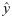
Liquid-state machine computations. In order to test the functional impact of the AIS location and the bandwidth of the transfer gain, we simulated a network of exponential Integrate-and-Fire (eIF) units using parameters fit to models with different AIS locations (see Fig 6 and Table 3). (A) The input was fed to a pool of recurrently connected neurons (black and blue: excitatory, red: inhibitory). Neurons were connected randomly through dynamic synapses. The filtered spikes (liquid states) of a subset of excitatory neurons (output neurons, blue), was used as input to a linear classifier. (B) The network input consisted of jittered versions of two base spike templates. (C) The classifier was trained to compute a XOR of the last two shown templates (top) using the spikes of the output neurons (blue) in the liquid (middle). As performance criterion we recorded how often the readout response y (bottom) matched the target output y^ (correct outputs are shown in green, incorrect outputs in red) for the parameters for different AIS locations (e.g. the AP slope ΔT). (D) The fitted ΔT values are shown versus the soma-AIS distance. The insets show the change of the slope at the AP onset from the first to the last AIS position. (E) As we varied the AIS locations, the Liquid State Machine performance improved in the classification task. The effect was significant for the first two distance increments (50 runs, Wilcoxon rank-sum test, * = p < 0.05, ** = p < 0.005, etc.).